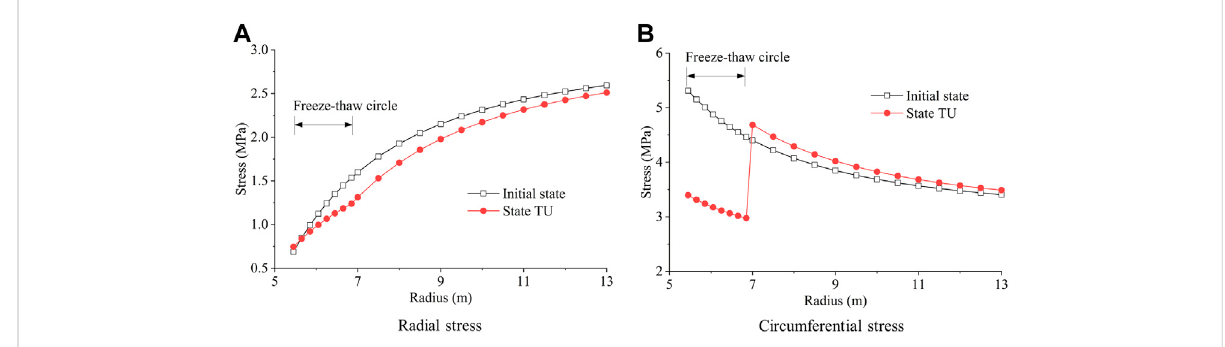
FIGURE 7 Stress of surrounding rock under initial state and state